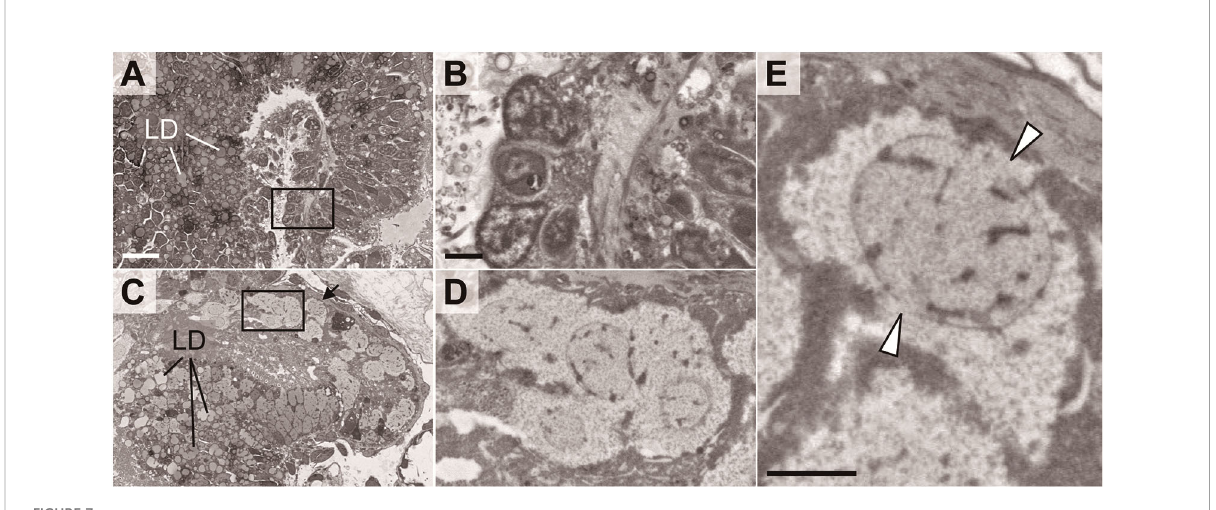
FIGURE 7 Abnormal morphologies of digestive tract in chimeric juveniles. Sibling chimera (A, B) and dead allogeneic chimera (C – E) shown in Figure 6. LD, lipid droplet. Black boxes in A, C are shown enlarged in B, D , respectively. (E) Cell indicated by arrow in (C) Arrowheads: segmented nuclear membrane. Scale bars: 10 µm (A) , 2 µm (B, E)